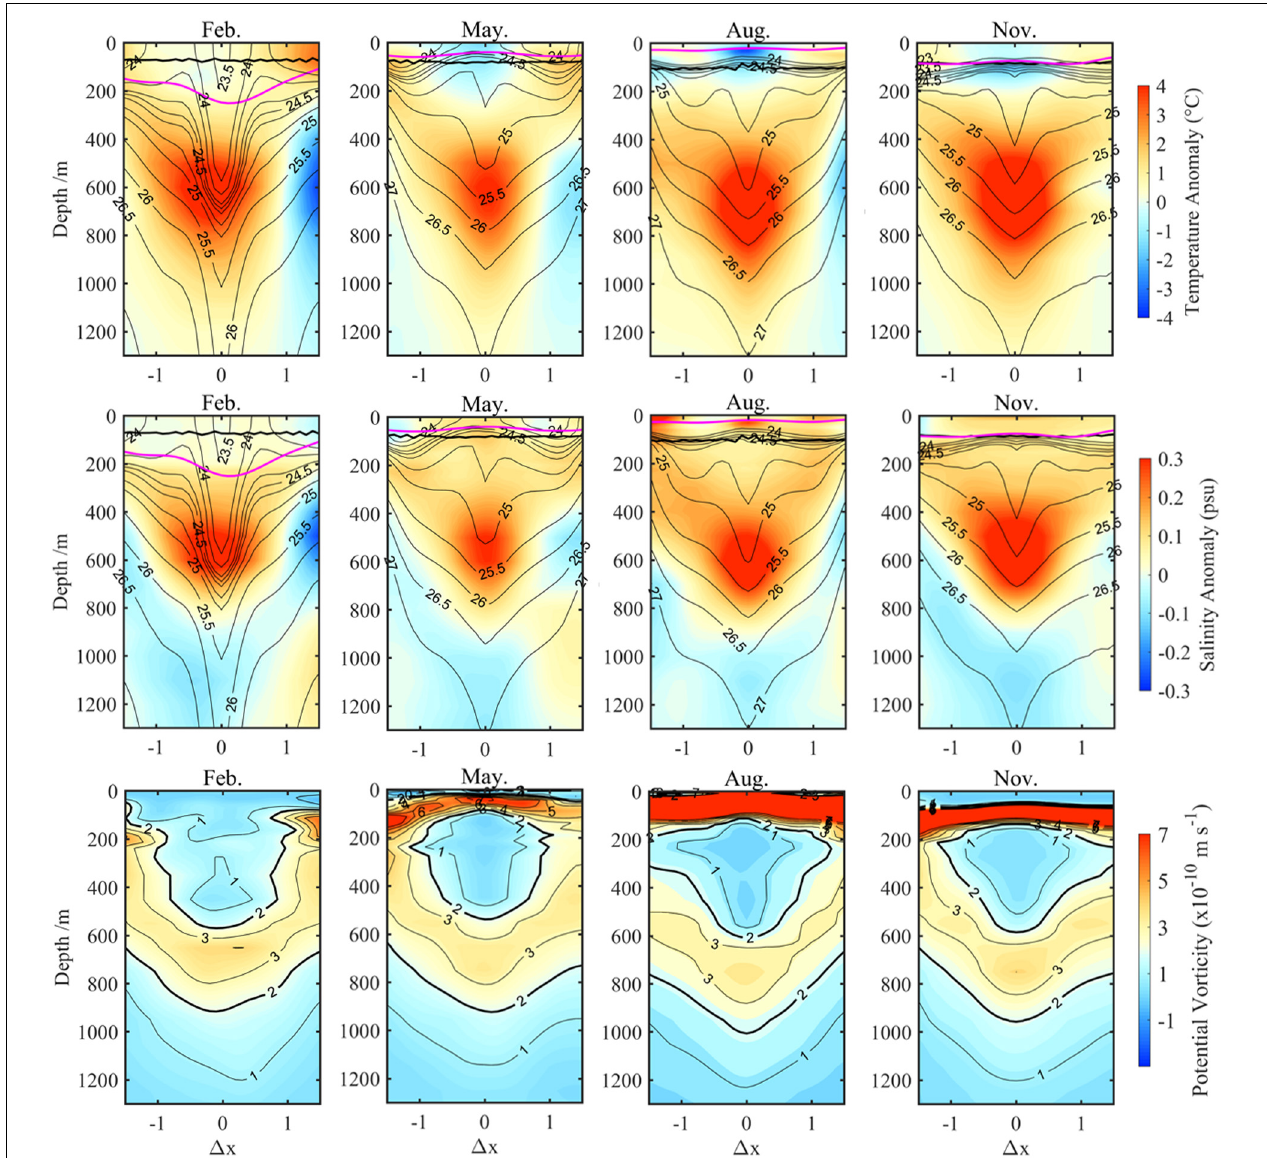
FIGURE 5 | Composite monthly vertical sections of SSAE in February, May, August, and November during the LM path period. Top-to-middle rows show zonal sections of temperature anomalies (color, unit: ◦ C), salinity anomalies (color, unit: psu), and potential density (contour, unit: kg m − 1 ). The magenta lines indicate the MLD, and the black lines indicate the base of ZEU; the bottom row shows the potential vorticity (color and contour, unit: m s − 1